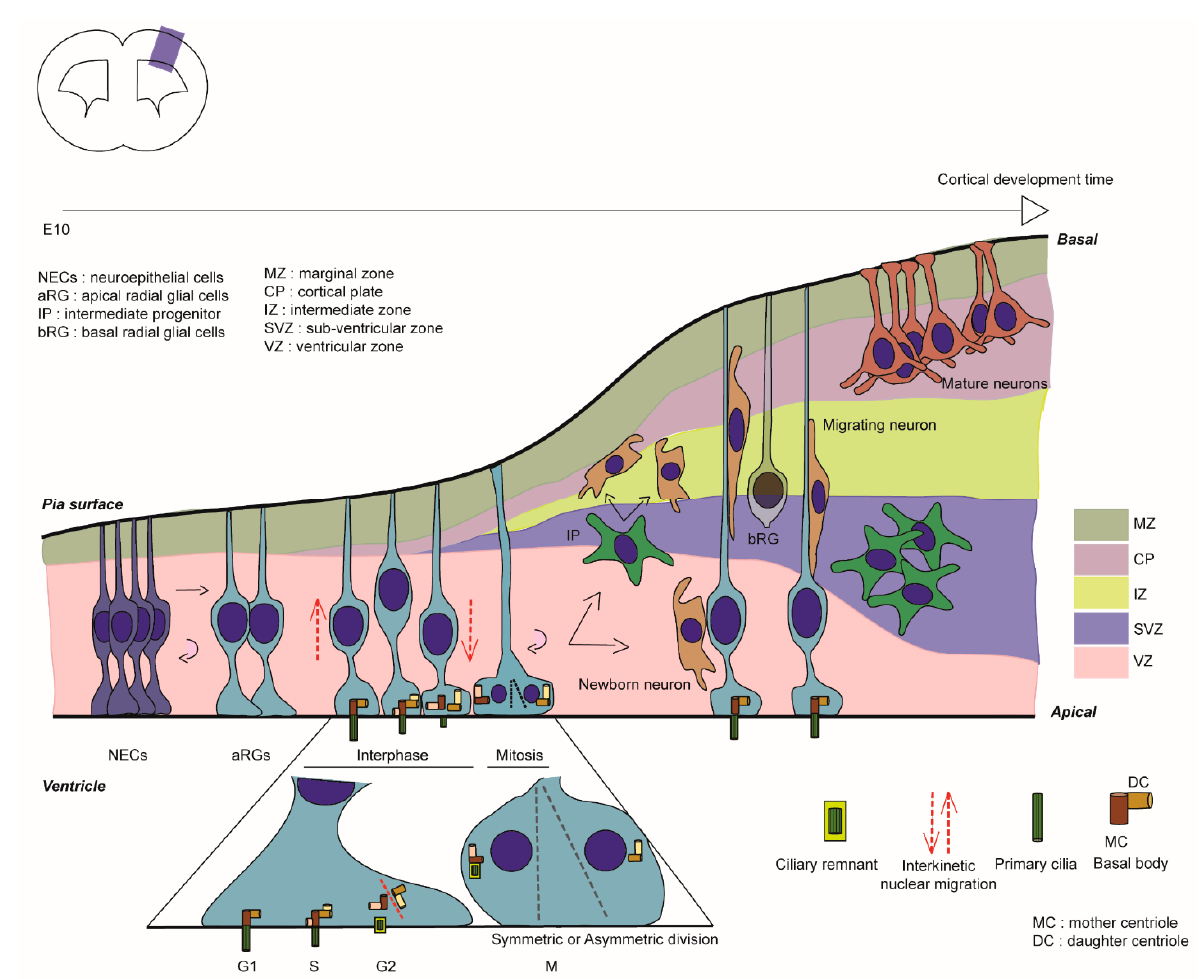
Figure 1. Cortical development in mouse. Graphical representation of mouse cortical development. Colour codes have been used to represent the different regions in the developing cortical